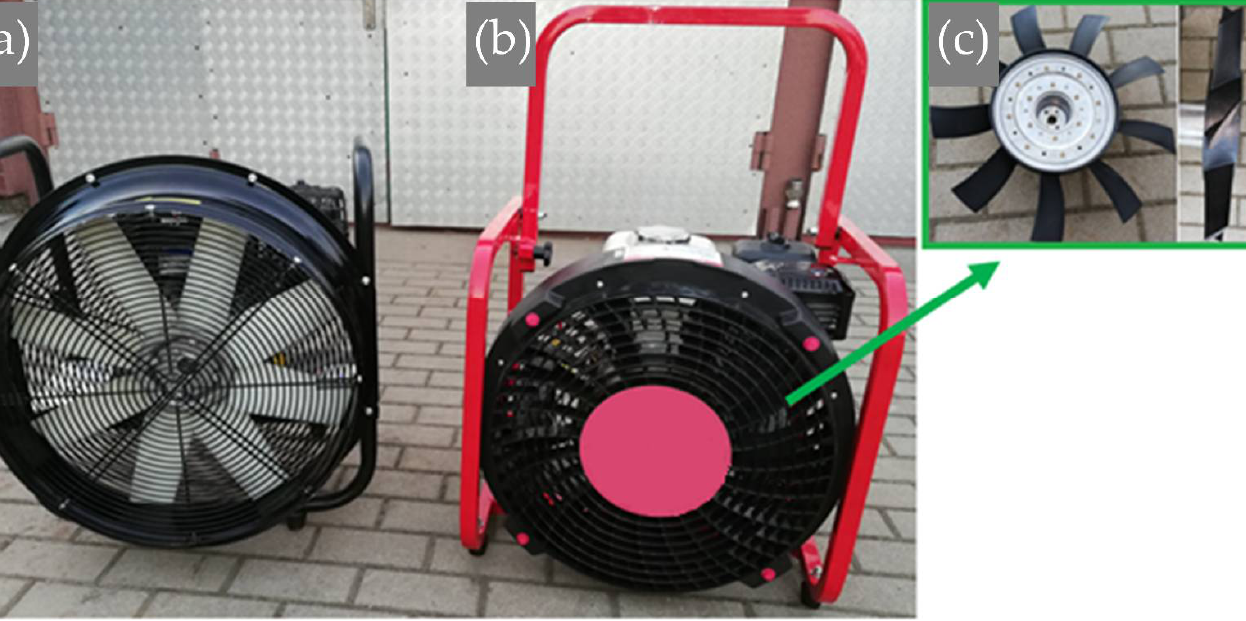
Figure 1. Mobile positive pressure fans used in rescue operations: ( a ) conventional fan, ( b ) turbo fan (W2), and ( c ) turbo fan impeller. Table 1. Declared performance of the mobile fans.